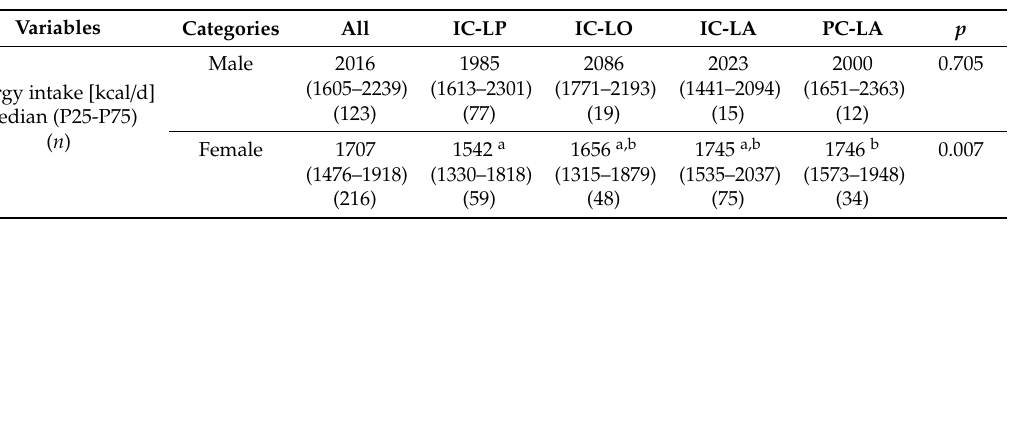
Table A1. Participants’ Energy and Protein Intake According to Living Situation and Type of